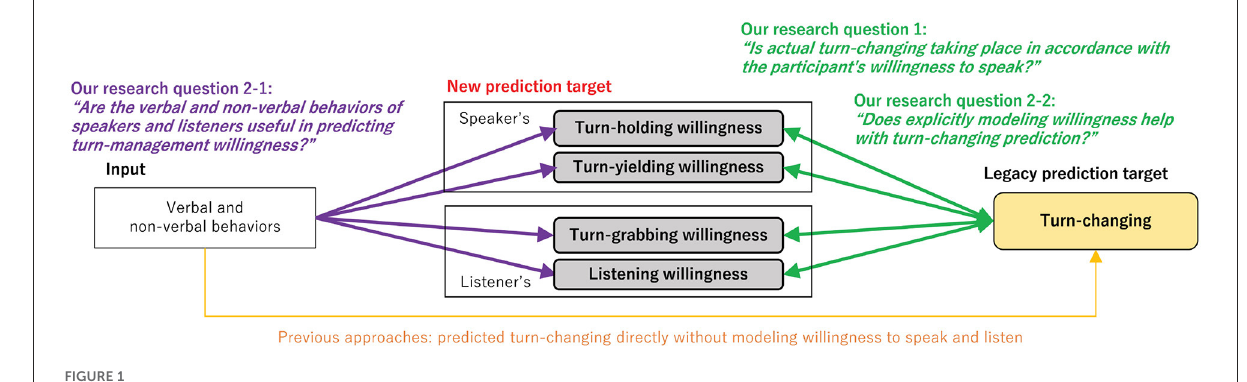
FIGURE1 Overview of our research